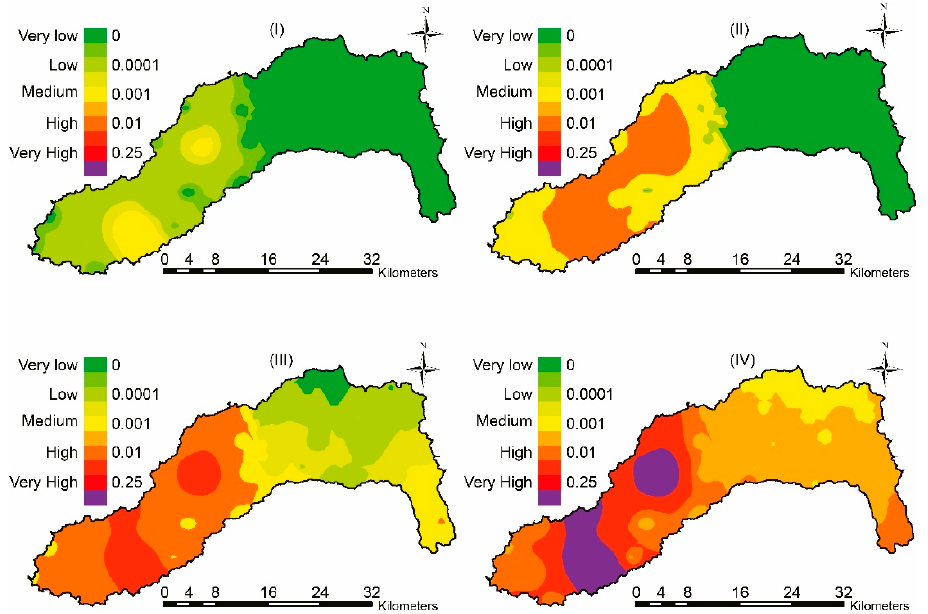
Figure 6. Leaching potential of Picloram in Jazan watershed as assessed by EAF index model under four leaching potential scenarios: low, 0.0003 m d − 1 (I); medium, 0.0005 m d − 1 (II); high, 0.001 m d − 1 (III); and very high recharge rate, 0.002 m d − 1 (IV).